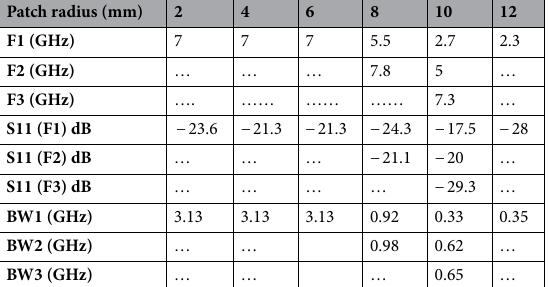
Table 11. Electrical details of Antenna4 topology with respect to patch radius variations using a feedline length of 17 mm.